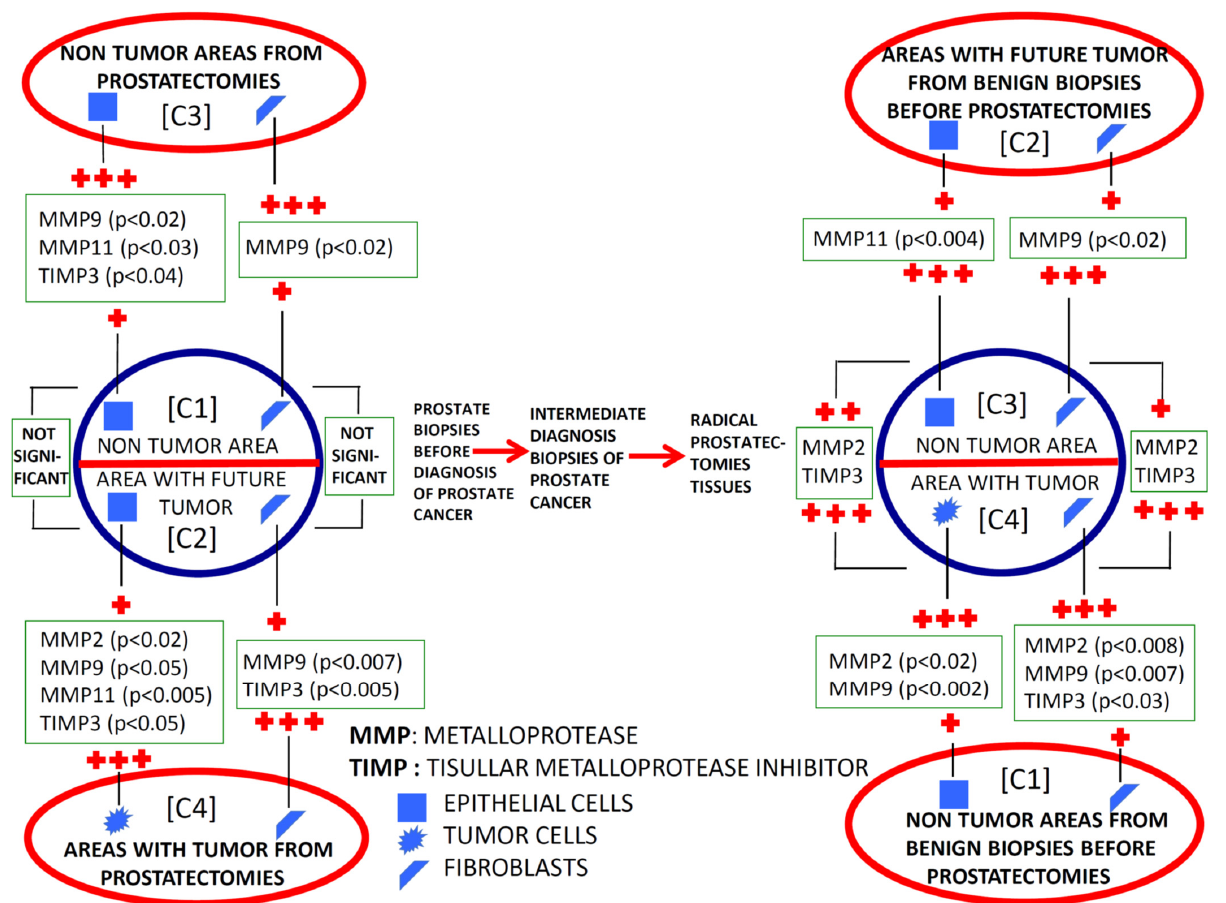
Figure 6. Schematic comparative study of the expression of MMPs and TIMP-3 by epithelial cells and by fibroblasts from benign prostate biopsies before the diagnosis of prostate cancer (non-tumor zones and zones with future tumor), and from paired zones from prostatectomies by prostate cancer